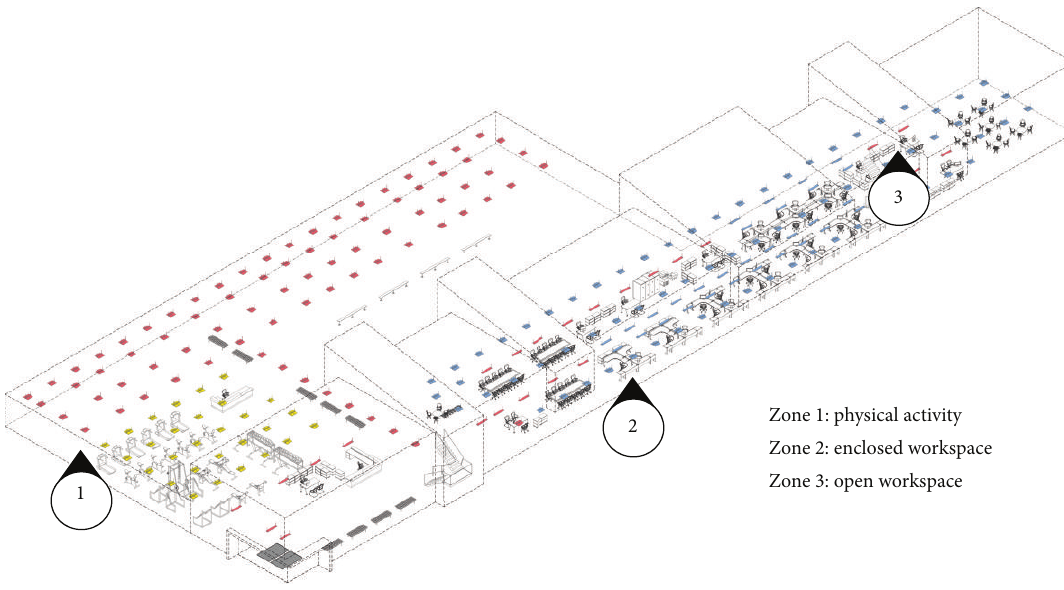
Figure 2: The building major